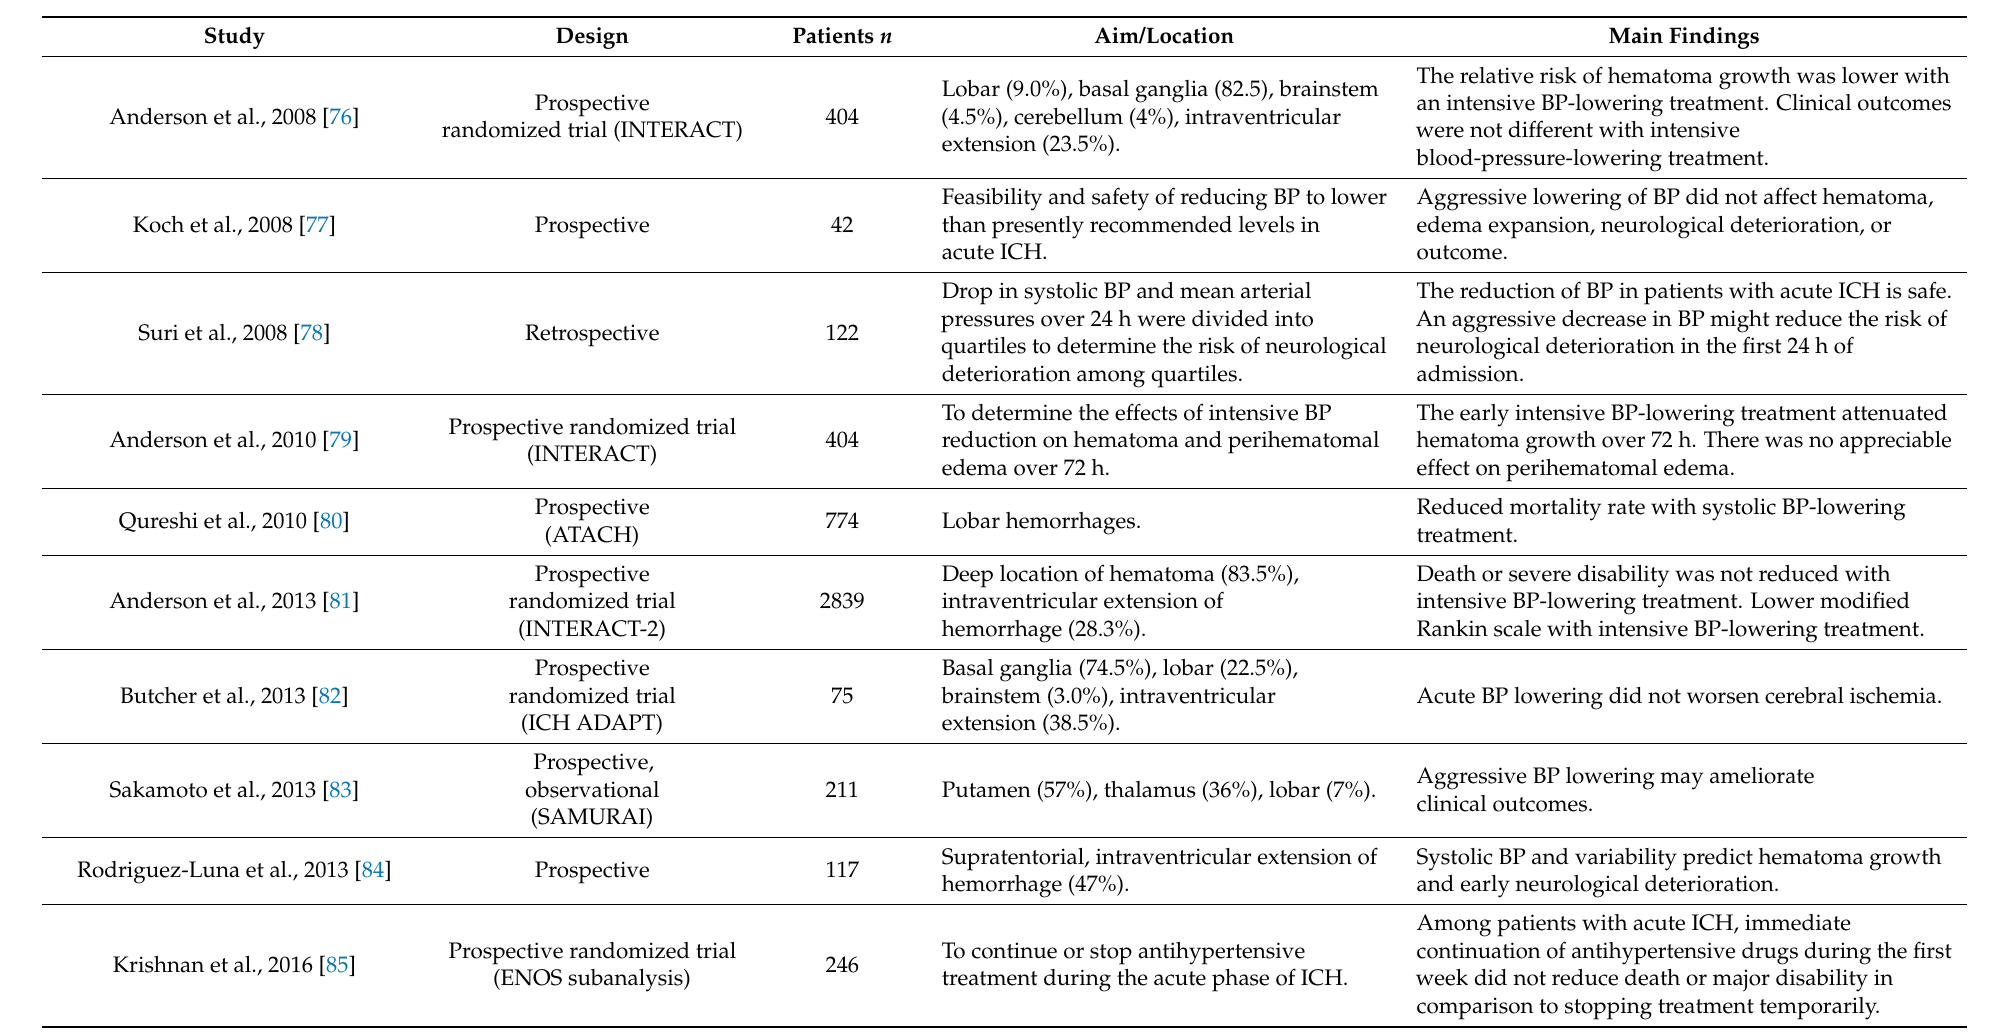
Table 2. Relevant studies on hypertensive crisis and intracerebral